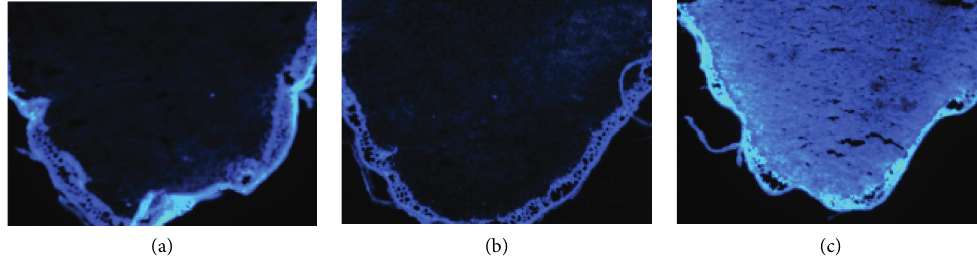
Figure 5: The fluorescent images of wheat germ slice tissues. (a) Blank experiment. (b) The fluorescent images of wheat germ slice tissues pretreated with NEM (0.5mM) for 5min and then incubated with KL-DN (20 μ M) for 5min. (c) The fluorescent images of wheat germ slice tissues incubated with KL-DN (20 μ M) for 5 min. Scale bar � 500 μ